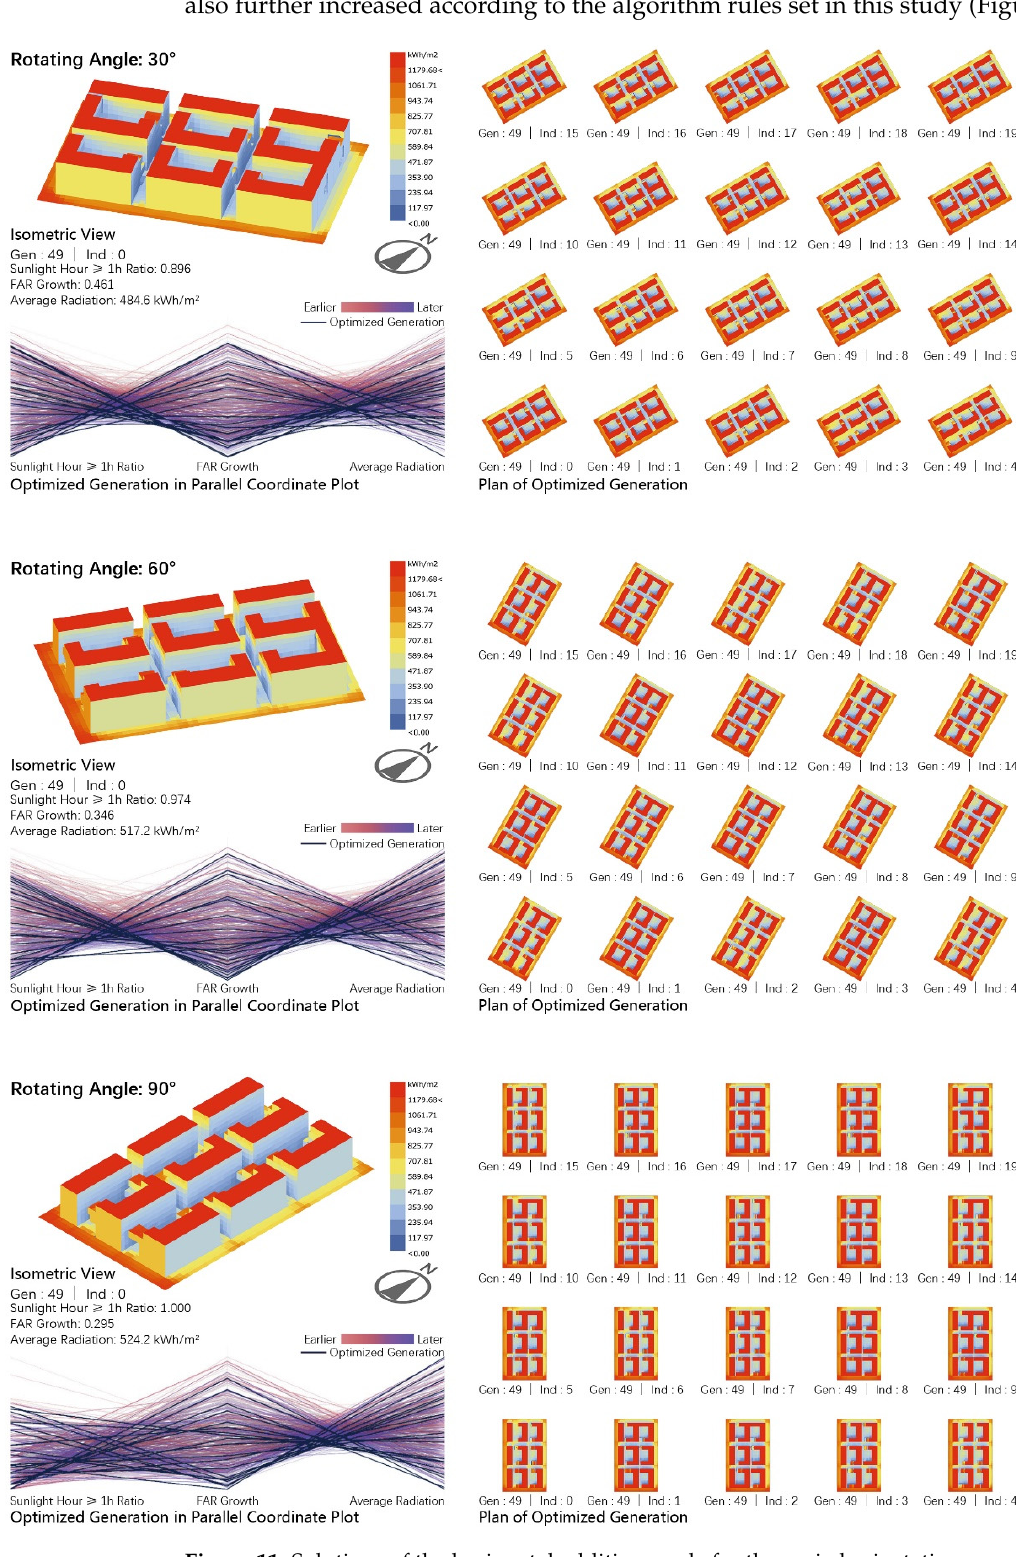
Figure 11. Solutions of the horizontal addition mode for the varied orientations.